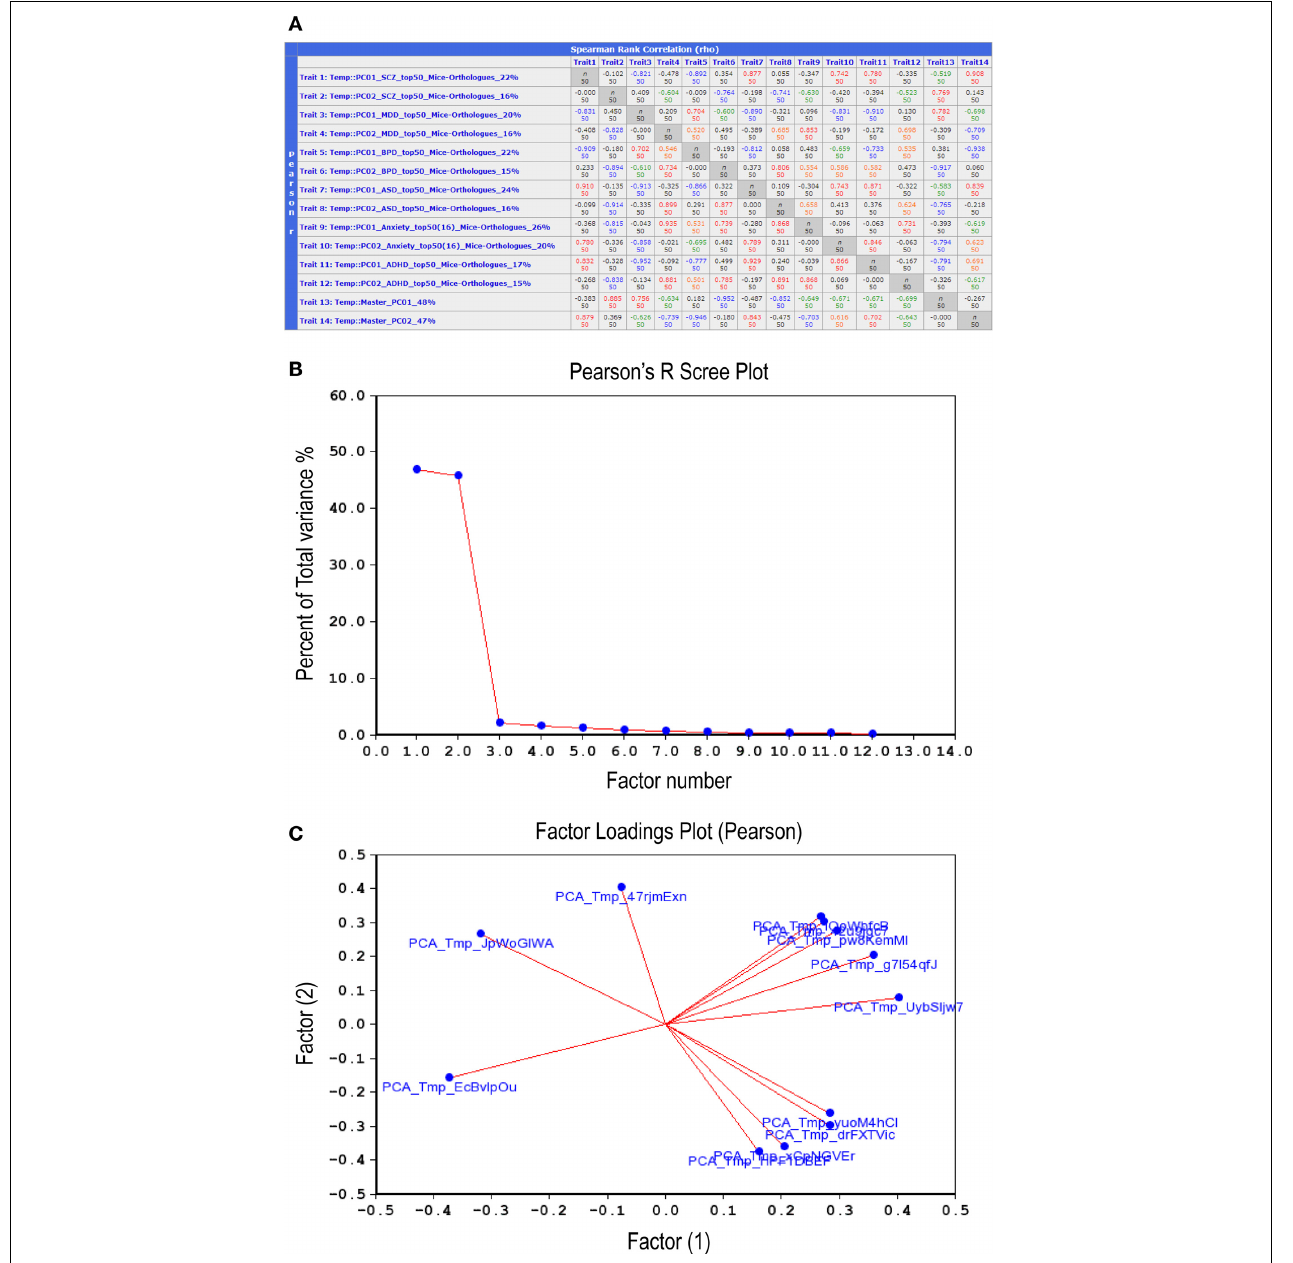
FIGURE 6 | Correlations between the top-12 synthetic PC traits. (A) Second-order correlations between all 12 synthetic PC traits, two per disorder, are depicted. The number appearing at the end of each trait name (first column) denotes the percent of total variance for each PC generated from a disorder’s top-51 gene-set mouse orthologs co-expression vector. The bottom two rows depict the second-order (termed Master) PCs that were generated by correlating the 12 synthetic PC traits amongst themselves. Lower left cells list Pearson